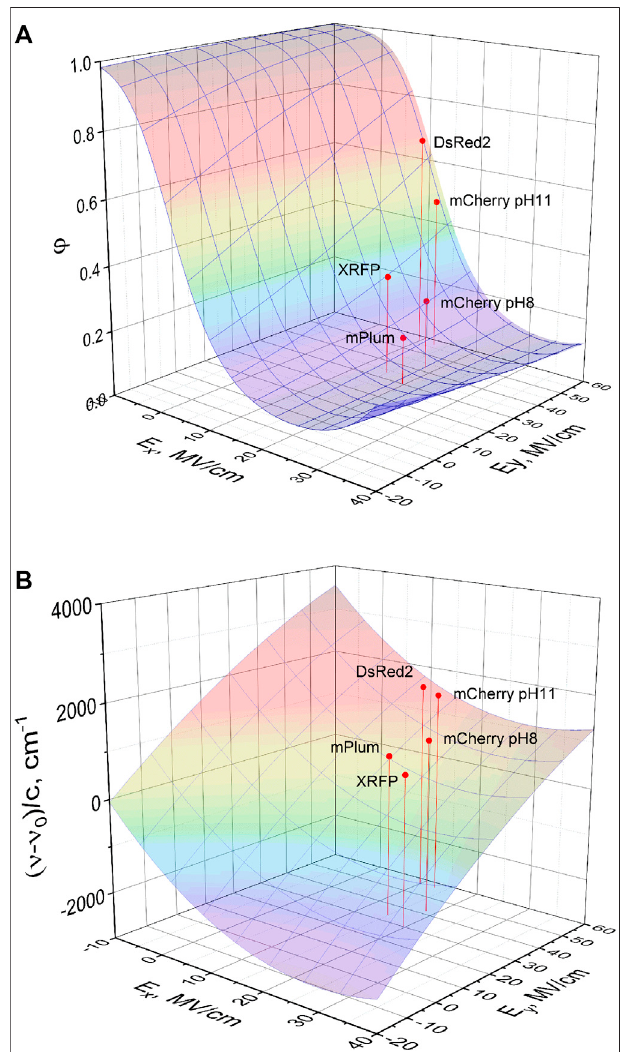
FIGURE 9 | 3D plot representing quantum yield (A) and shift of peak absorption transition frequency relative to the vacuum frequency (B) as a function of E x and E y in a set of RFPs with a “ moderately-soft ” phenolate pocket(seetext).FiverepresentativeRFPsareshownbyreddots.Large quantum yields in (A) correspond to red and small quantum yields — to purple color of the surface. The calculation is based on model Eqs 2 , 33 – 36 and model parameters presented in Table 4 . Large negative shifts in (B) corresponds to purple and large positive shifts — to red surface color. The prediction is based on Eq. 15 and parameters from “ Parameters of the Isolated RFP Chromophore Calculated Quantum Mechanically ”